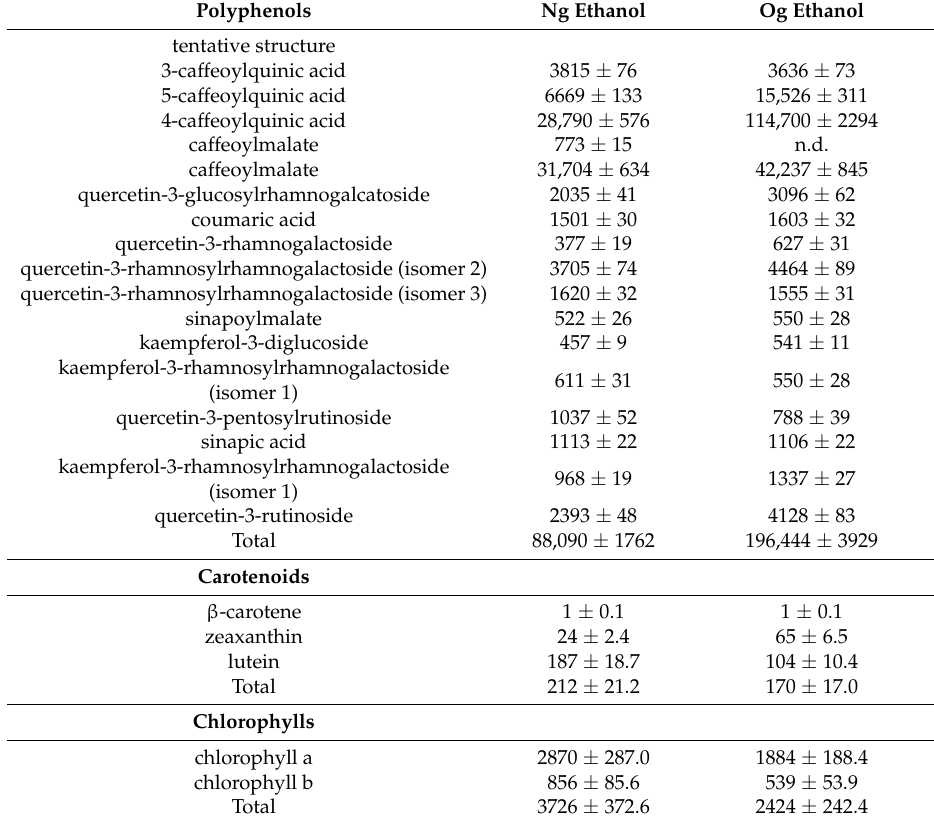
Table 4. Phytochemical content in the extracts of raw vs. fermented S. scabrum grown in Normal-greenhouse (Ng) vs. Open-greenhouse (Og) in µ g/g DM (location B). The data are presented as phytochemical content ± average analytical